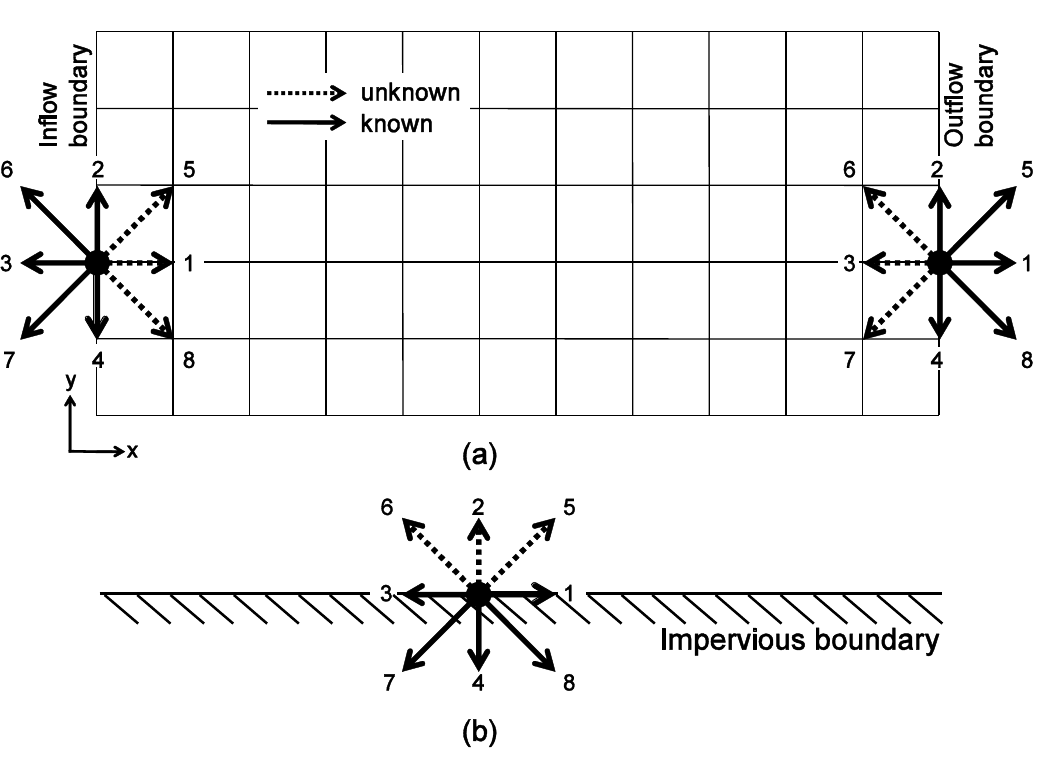
Figure 1. Lattice nodes for ( a ) periodic boundary or open boundary, and ( b ) impervious boundary.